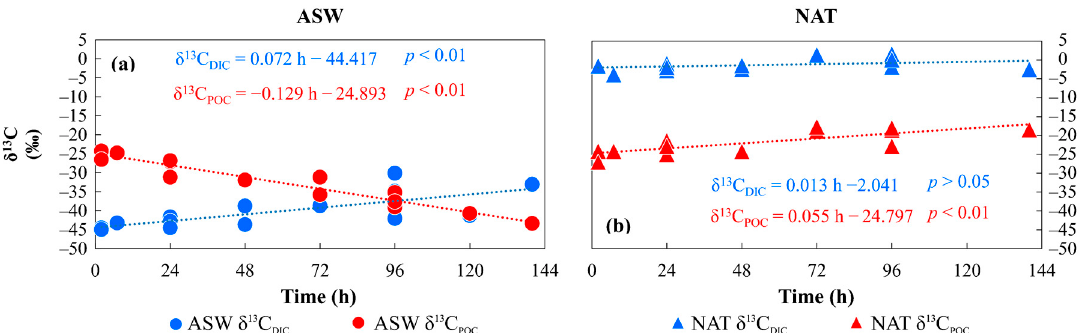
Figure 6. Comparison between the time variation of the isotopic composition of DIC ( δ 13 C DIC, in blue), and phytoplankton ( δ 13 C POC, in red) during the three T. rotula culture experiments in ( a ) artificial seawater medium (ASW) and ( b ) natural seawater medium (NAT). Linear regression (dashed lines) equations and correlation significance are provided in each box for both the δ 13 C DIC and δ 13 C POC .